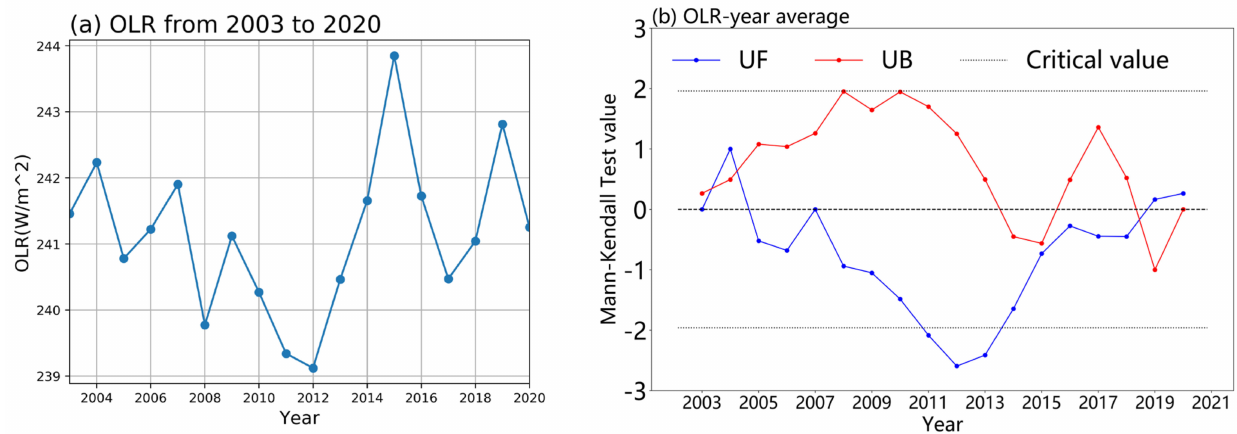
Figure 3. OLR annual mean change and MK analysis. ( a ) Annual mean change. ( b ) MK analysis OLR-year